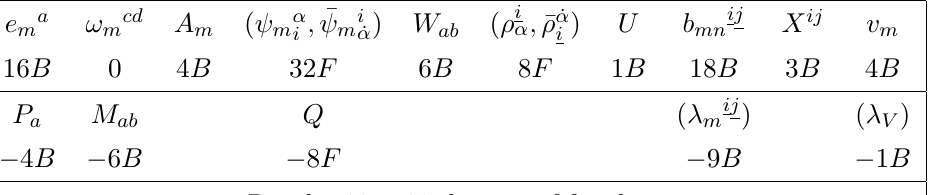
Table 5 . Hyper-Dilaton Poincaré multiplet. Row 1 gives all fields in the multiplet. Row two gives the number of independent components of these fields. Row three gives the surviving gauge symmetries. Row four gives the number of gauge degrees of freedom to be subtracted when counting the total degrees of freedom. Row five gives the resulting degrees of freedom. The parameter λ mij describes the vector symmetry associated with the triplet of gauge two-form b mnij . The gauge parameter λ V describes the scalar symmetry of v m